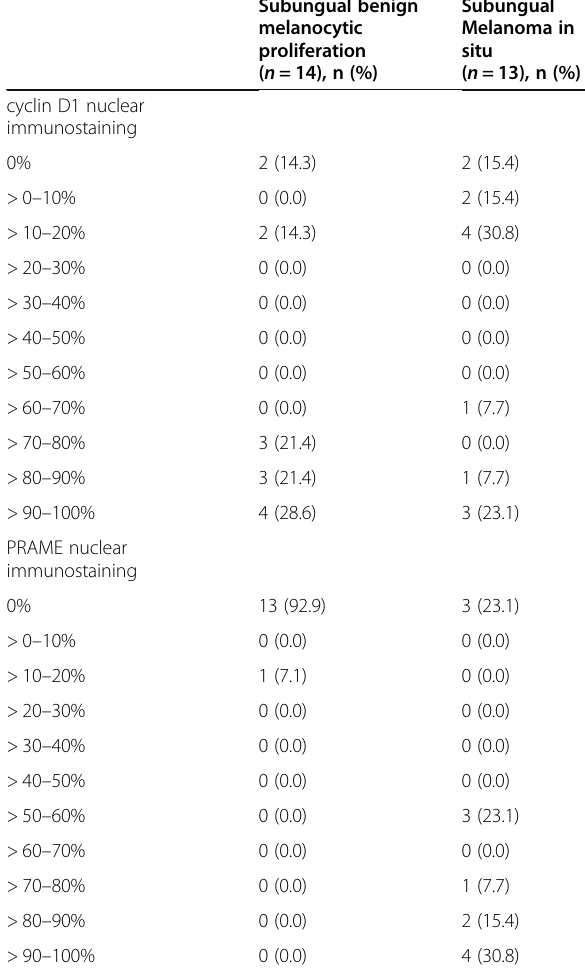
Table 3 Immunohistochemistry staining of subungual benign melanocytic proliferation and subungual melanoma in situ